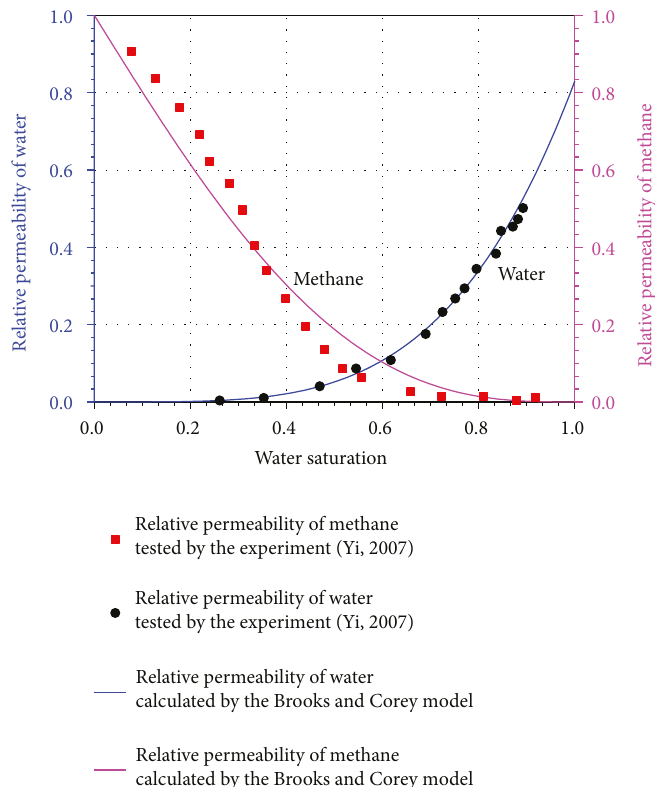
Figure 3: The permeability of water and methane in porous coal